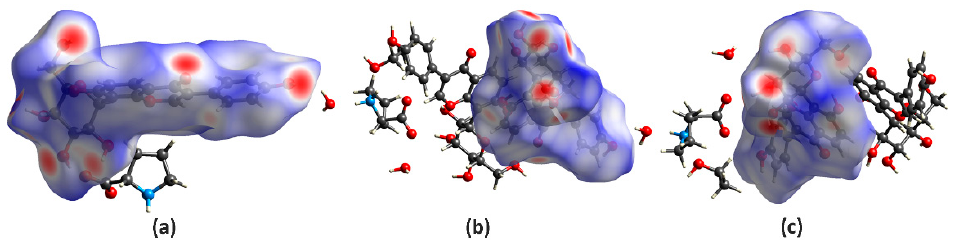
Figure 4. Hirshfeld surfaces for the PUE with its neighboring molecules in the crystals of I ( a ), II-A ( b ), and II-B ( c